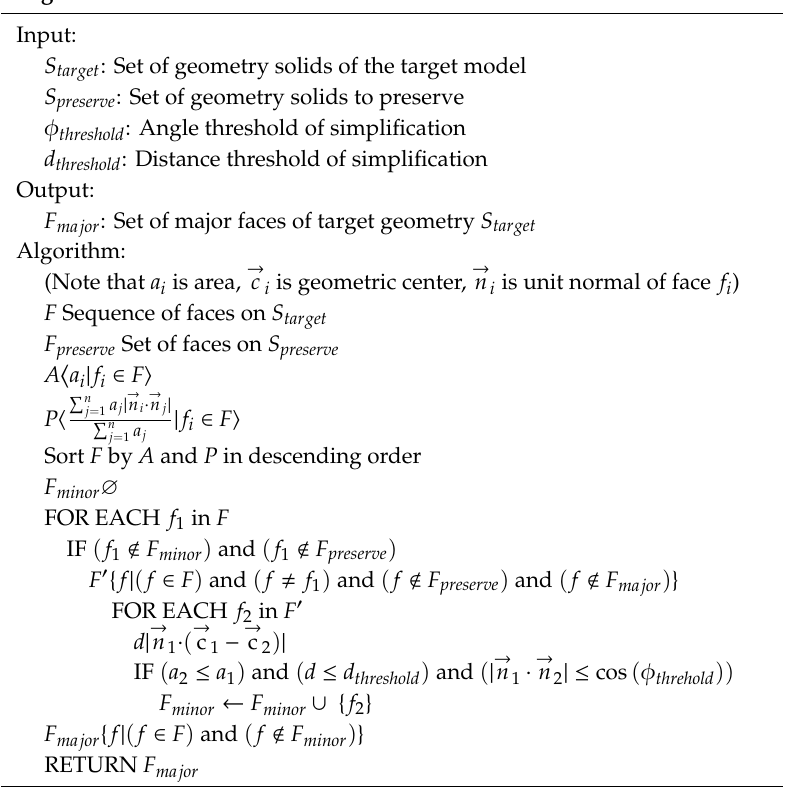
Algorithm 1 Pseudocode for face